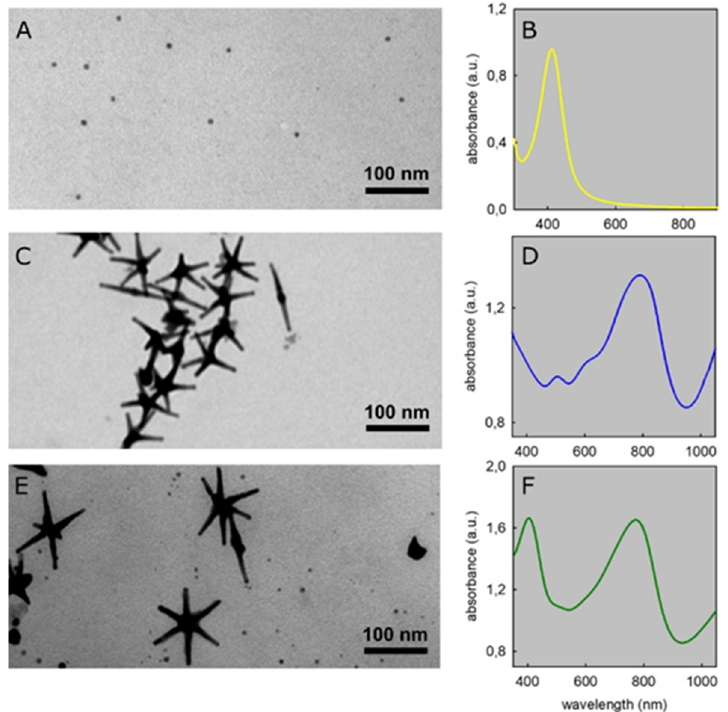
Figure 1. ( A , C , E ) TEM images obtained from solutions of AgNP, GNS and 1:2 AgNP:GNS solution mixtures, respectively. ( B , D , F ) Corresponding absorption spectra. Please note that spectrum ( B ) is displayed on the 350–900 nm range, while spectra ( D , F ) on the 350–1050 nm